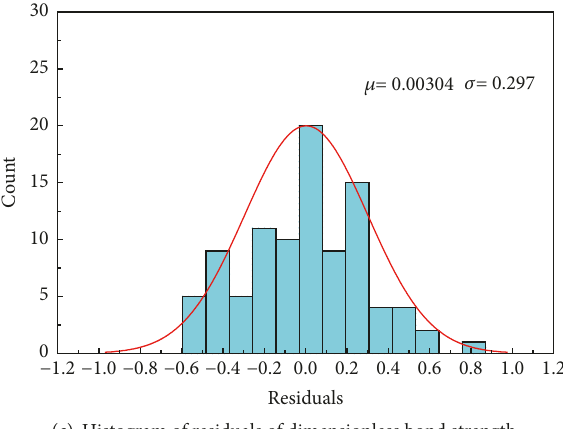
Figure 9: Dimensionless bond strength versus maximum crack width of pull-out specimens with deformed rebar: (a) dimensionless bond strength versus maximum crack width; (b) residuals versus maximum crack width; (c) histogram of residuals of dimensionless bond